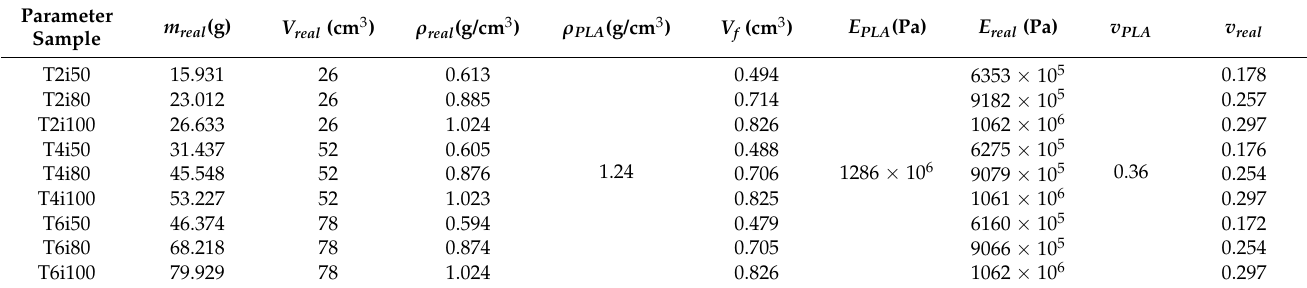
Table 2. Mass ( m real ) , volume ( V real ) and density ( ρ real ) of each PLA plate; PLA density ( ρ PLA ) ; volume of the fraction of PLA that occupies each plate ( V f ) ; PLA Young’s modulus ( E PLA ) and real Young’s modulus ( E real ) ; PLA Poisson coefficient ( v PLA ) and real Poisson coefficient ( v real )